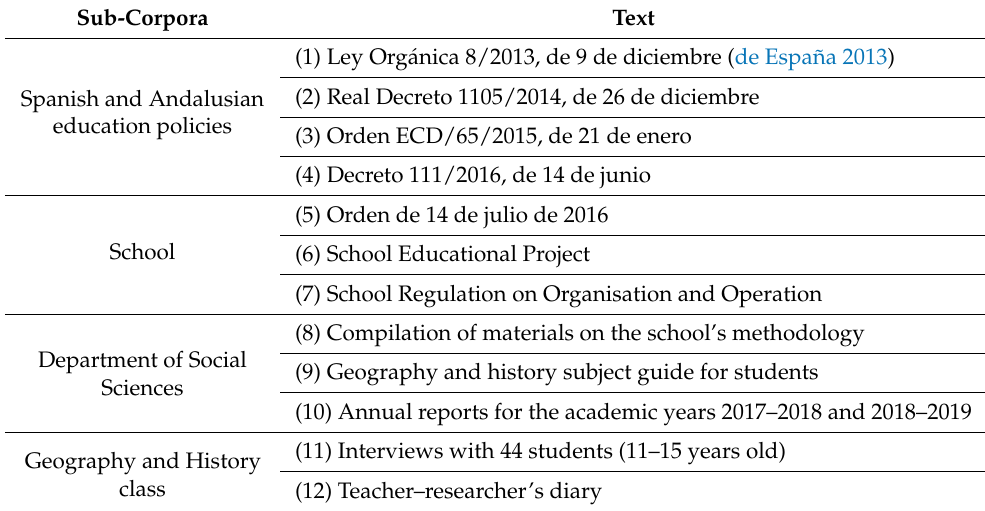
Table 1. Composition and organisation of the research corpus.